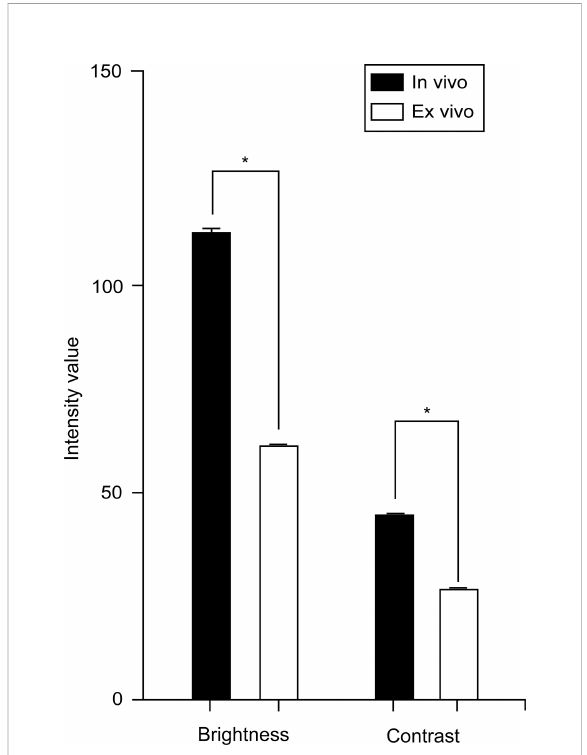
FIGURE 1 Bar chart showing a comparison of overall mean (SD) brightness and contrast of in vivo and ex vivo images. In vivo images had a mean brightness of 112.1 (26.9) and contrast of 44.7 (8.0). Ex vivo images had a mean brightness of 60.7 (23.6) and a contrast of 26.8 (7.9). In vivo images have higher brightness and contrast than ex vivo images (p < 0.001). Values are reported in optical density units de fi ned by the Fiji software. Asterisk indicates p < 0.001. Used with permission from Barrow Neurological Institute, Phoenix, Arizona .